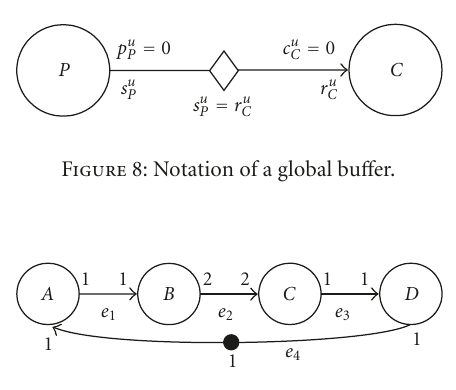
Figure 9: Some actors do not fire concurrently due to the schedule or the graph